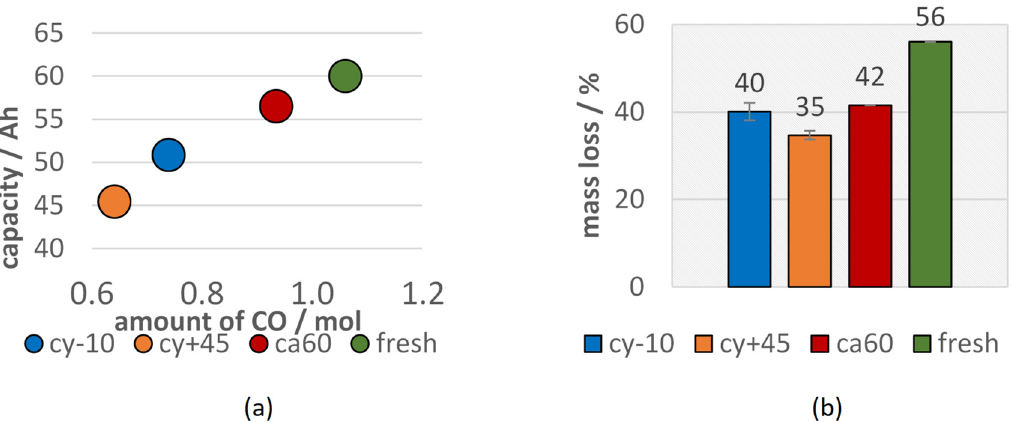
Figure 8. ( a ) Current capacity (Ah) of aged cells versus the amount of produced CO (mol) ( b ) mass reduction after TR of the aged (cy − 10: blue, cy+45: orange, ca60: red) type #1 cells in comparison to the fresh type #1 cells (green).